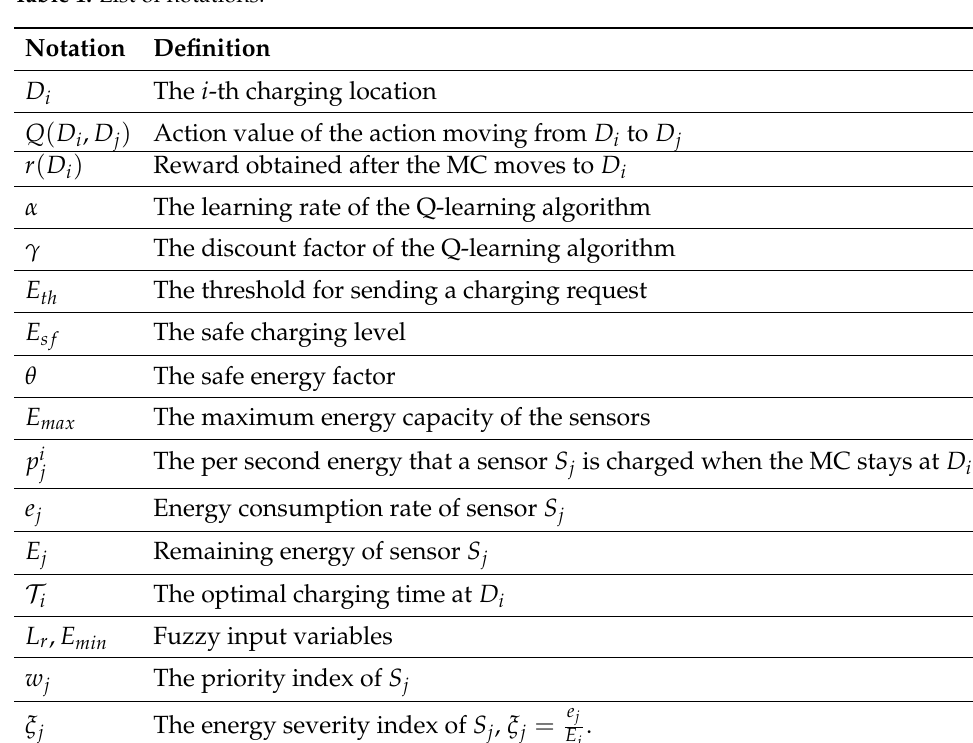
Figure 3. The flow of Fuzzy Q-learning-based charging algorithm. Table 1. List of